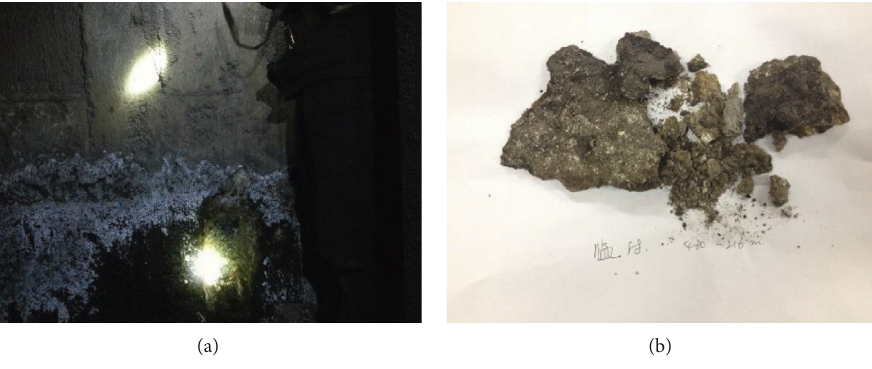
Figure 2: Corroded concrete ( − 271m).